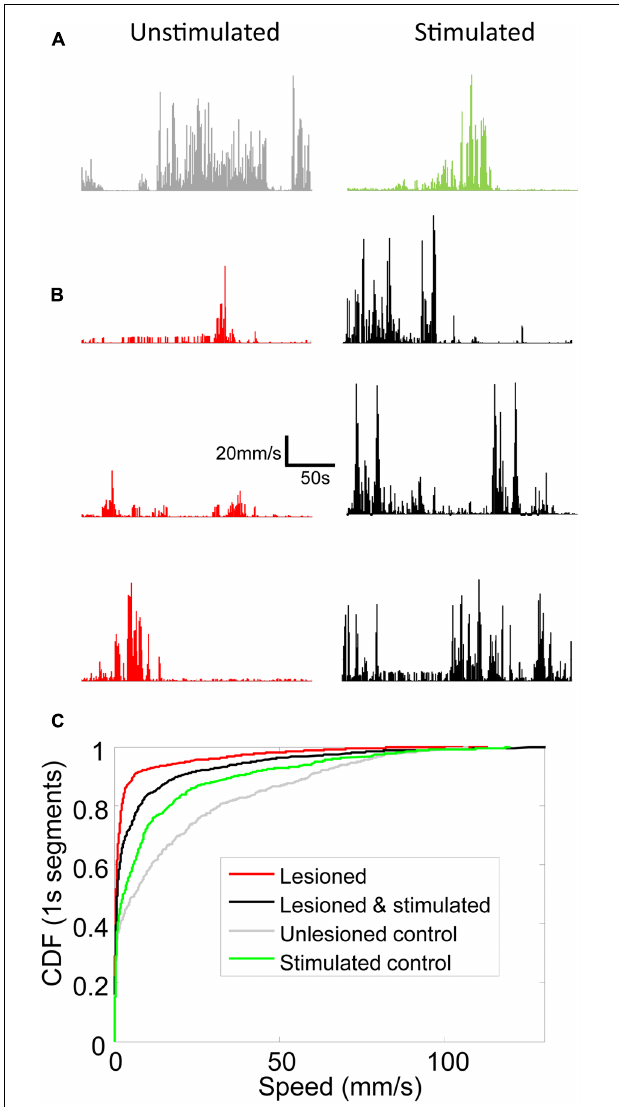
FIGURE 5 | Locomotion speed increased in lesioned mice receiving stimulation. Line graphs showing locomotion speed for each 1s of representative 5 min trials for (A) unlesioned control and (B) 3 individual lesioned mice. Left column shows unstimulated trials. Right column shows optically stimulated (100 Hz or 130 Hz) trials. (C) Cumulative distribution functions (CDFs) of locomotion speed for all trials in unlesioned control and lesioned mice with and without stimulation. Rightward shift of curve indicates more high speed 1s